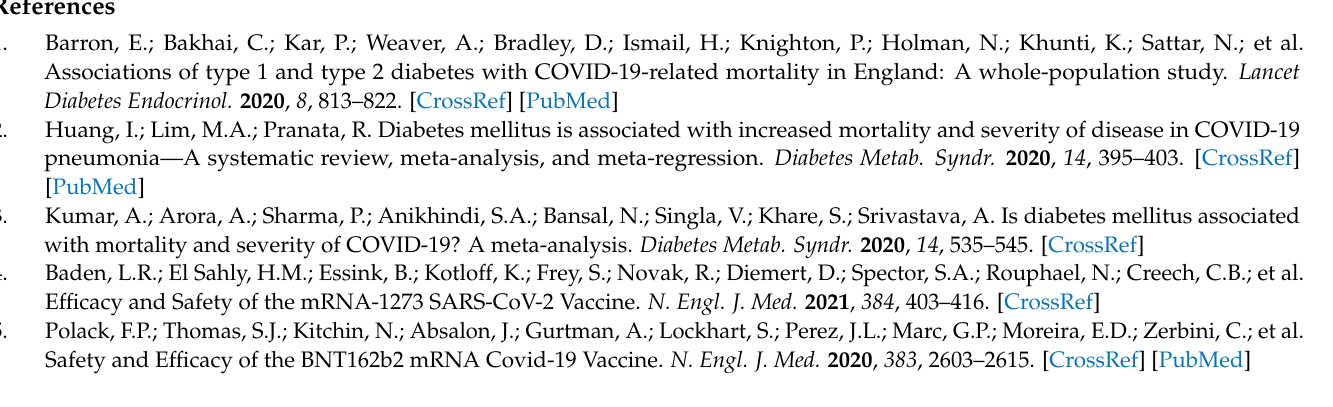
Table S2: Search strategy in Embase.com; Table S3: Search strategy in Clarivate Analytics/Web of Science Core Collection; Table S4: Search strategy in Wiley/Cochrane Library; Figure S1. Risk of bias by domain and overall, for each study separately; Figure S2. Risk of bias in included studies, by domain and